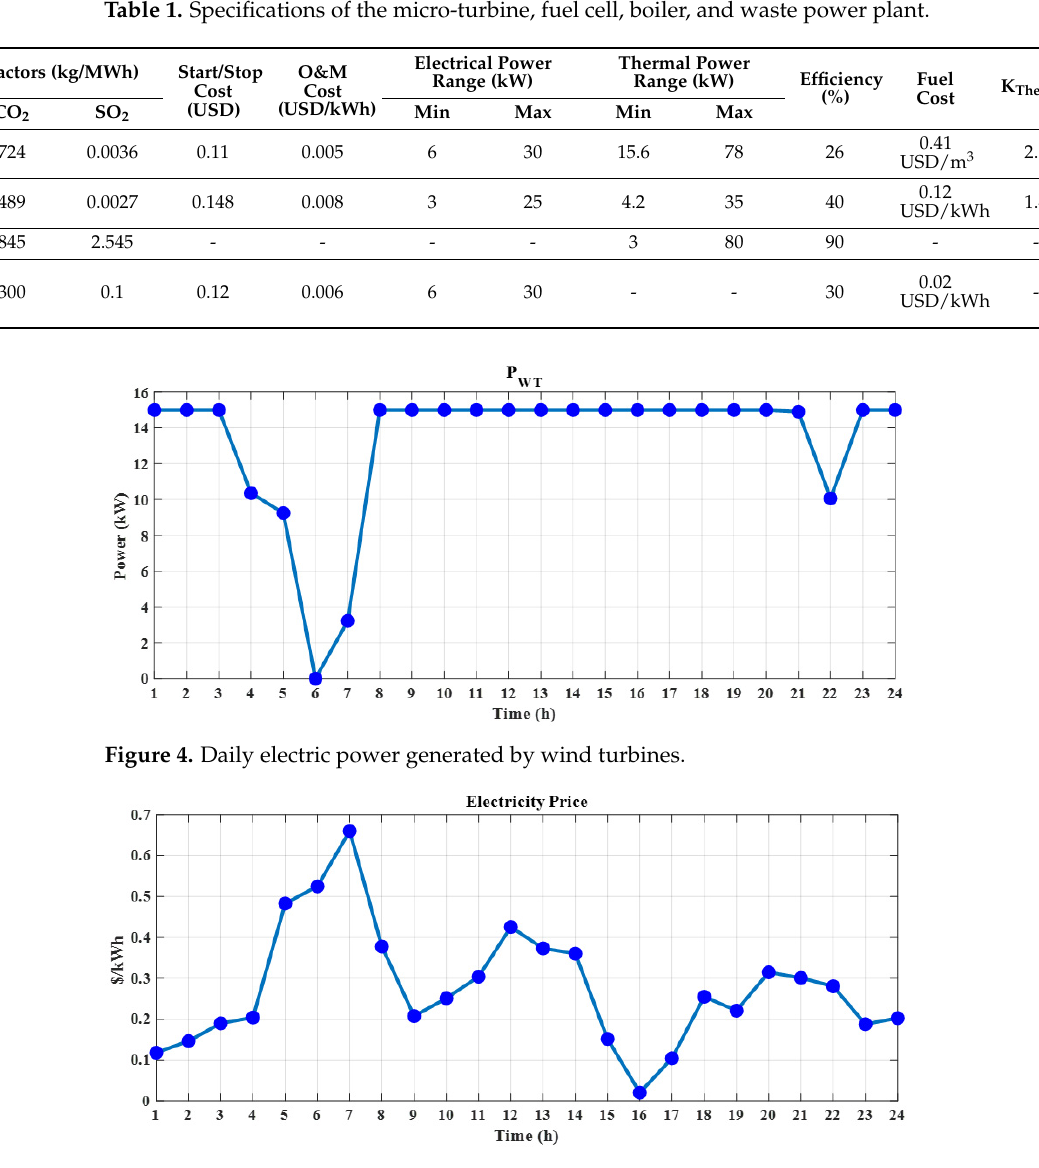
Figure 5. Daily electricity prices.